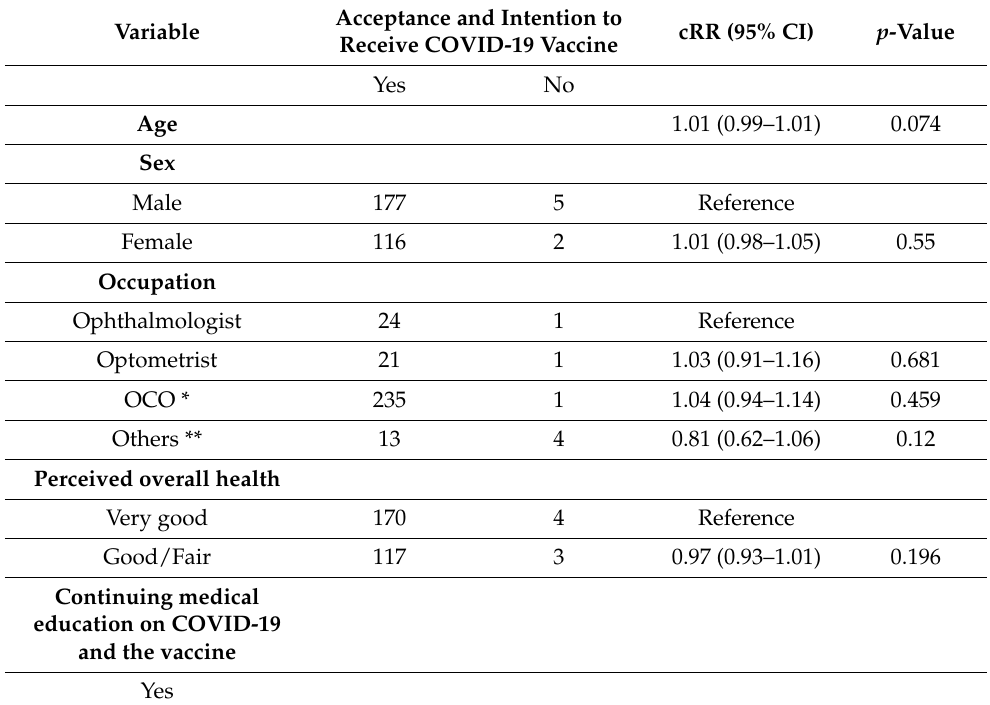
Table 3. Bivariable analysis of factors associated with COVID-19 vaccine acceptance among eye healthcare workers in Uganda ( n =